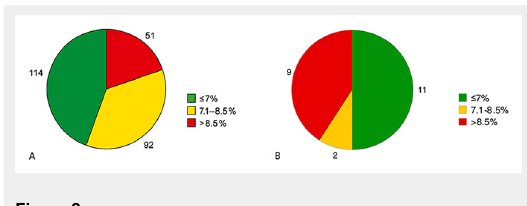
A. Distribution of glycated haemoglobin A1c (HbA1c) values in patients from group A (panel A) and group B (panel B). Figures indicate absolute numbers of patients in each HbA1c subgroup.